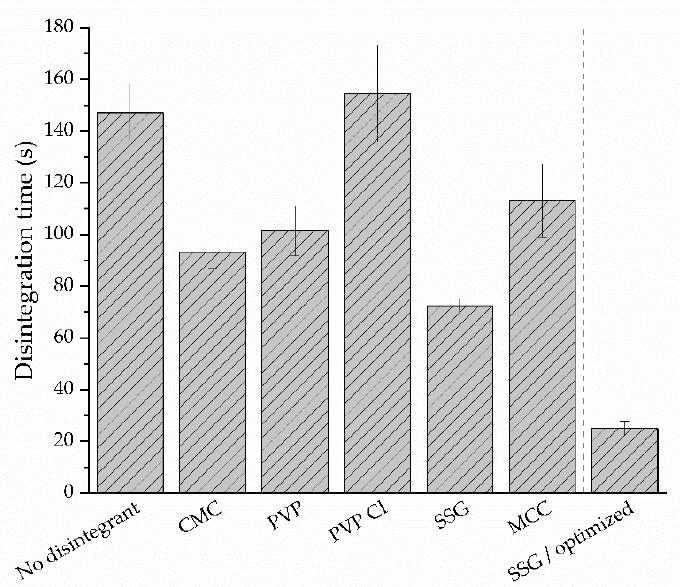
Figure 8. Disintegration times of the pre-formulations and the optimized formulation.